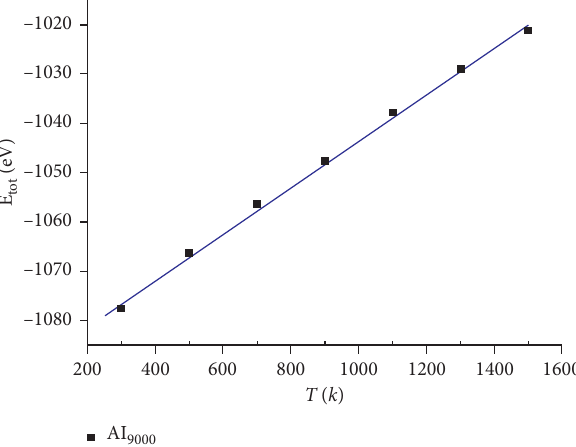
Figure 7: Dependence of energy on temperature for the bulk aluminium sample with N � 9000 atoms.